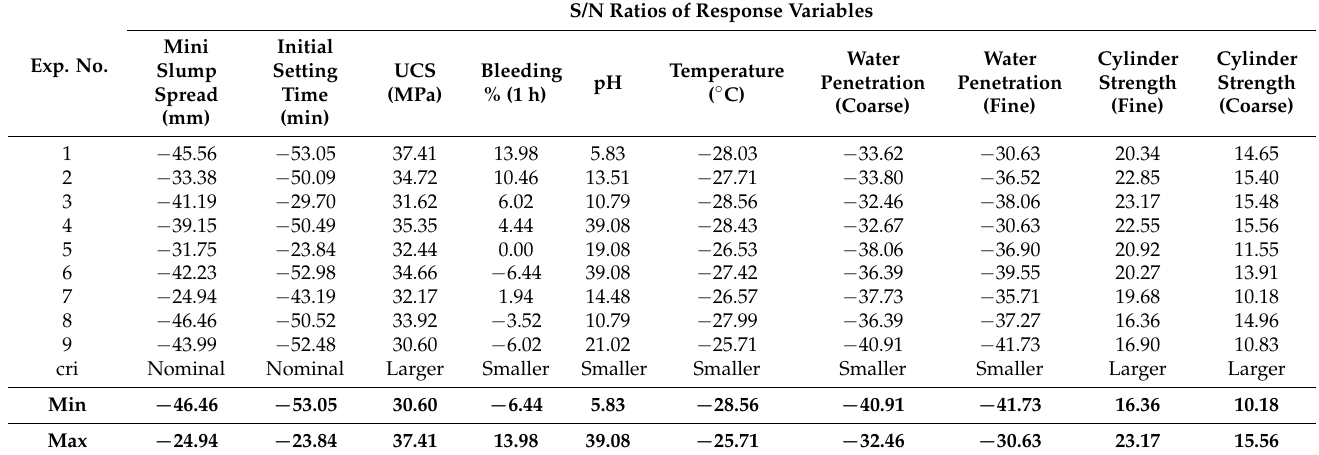
Table 8. S/N ratios of response variables.